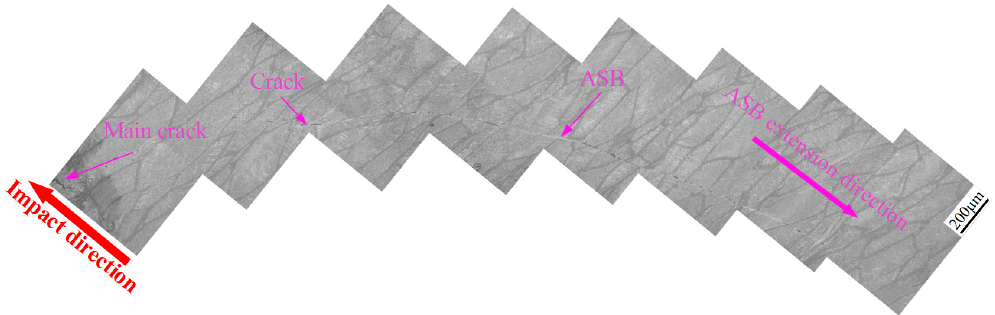
Figure 12. Optical micrographs showing microstructure of region 1 in Figure 11.